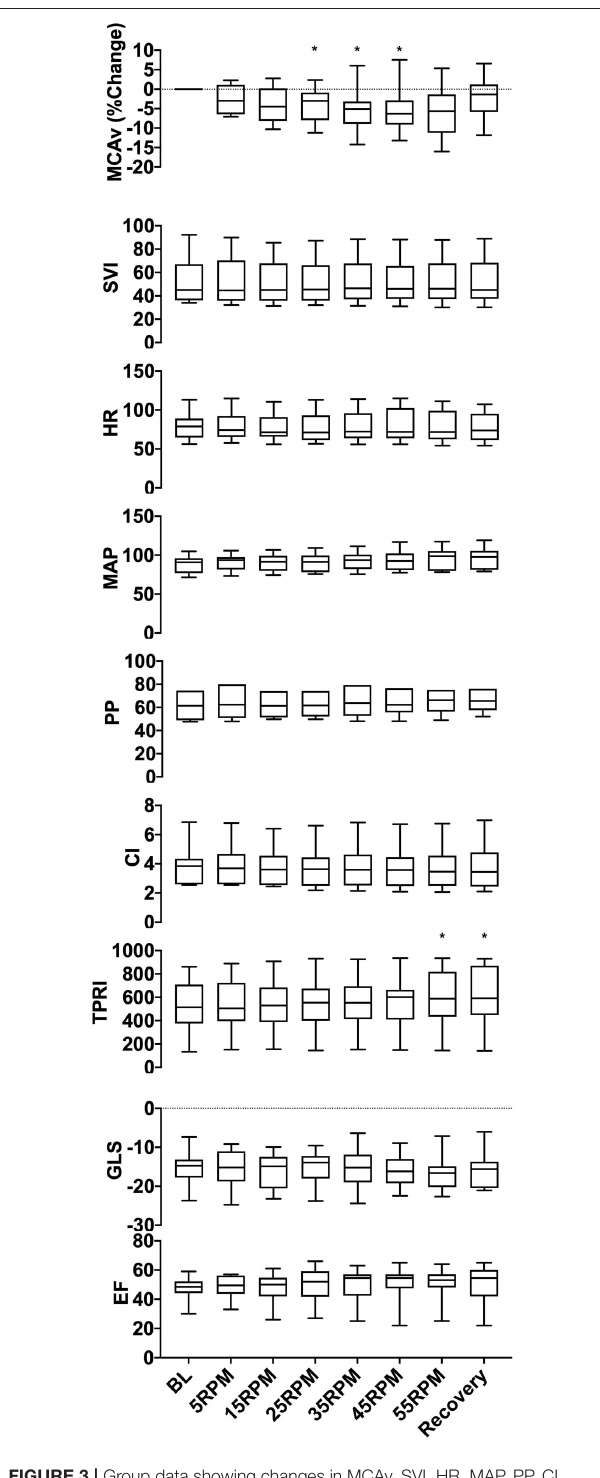
FIGURE 3 | Group data showing changes in MCAv, SVI, HR, MAP, PP, CI, TPRI, GLS, and EF with increasing cycling cadence. The box plots represent values averaged at each passive cycling stage across all patients. A significant decrease was seen in MCAv between 25 and 45 RPM ( p = 0.004), and an increase in TPRI was observed at 55 RPM ( p = 0.008), which persisted